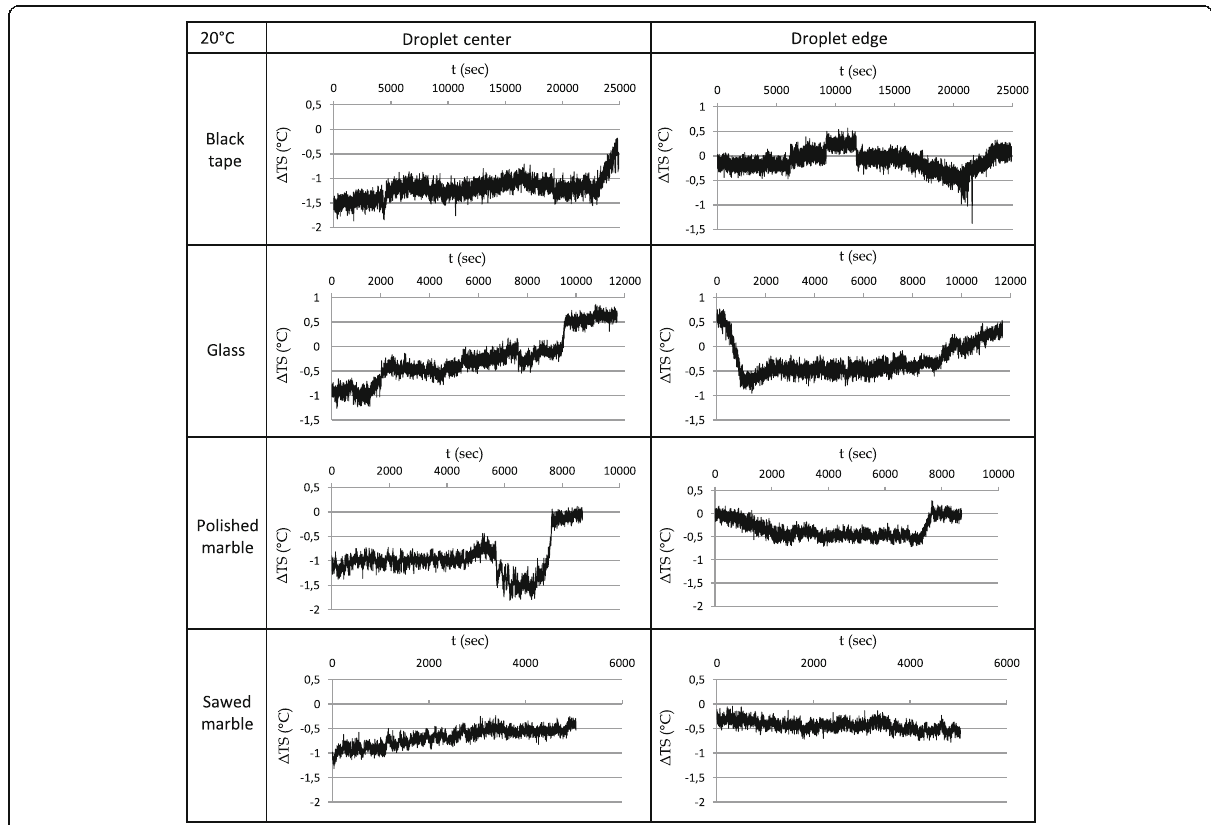
Fig. 5 IRT profiles of each droplet zone at 20 °C for each